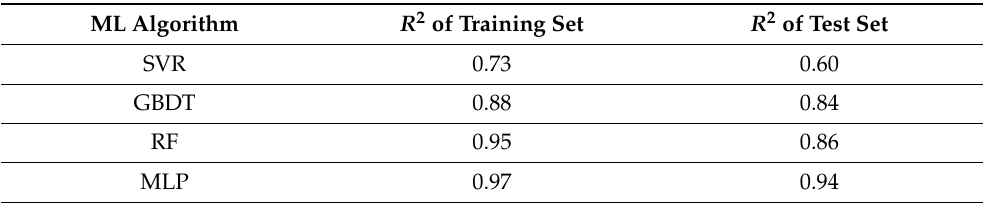
Table 3. Comparison of prediction performance of various